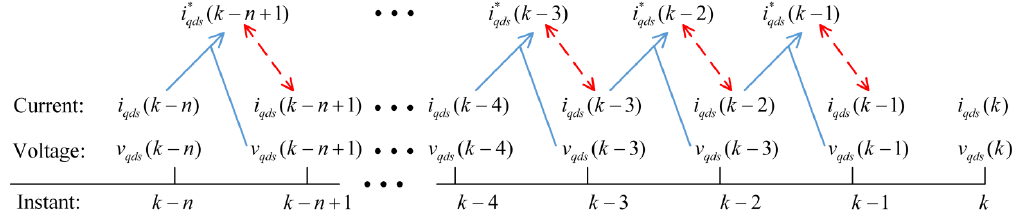
Figure 4. Proposed implemented algorithm diagram.